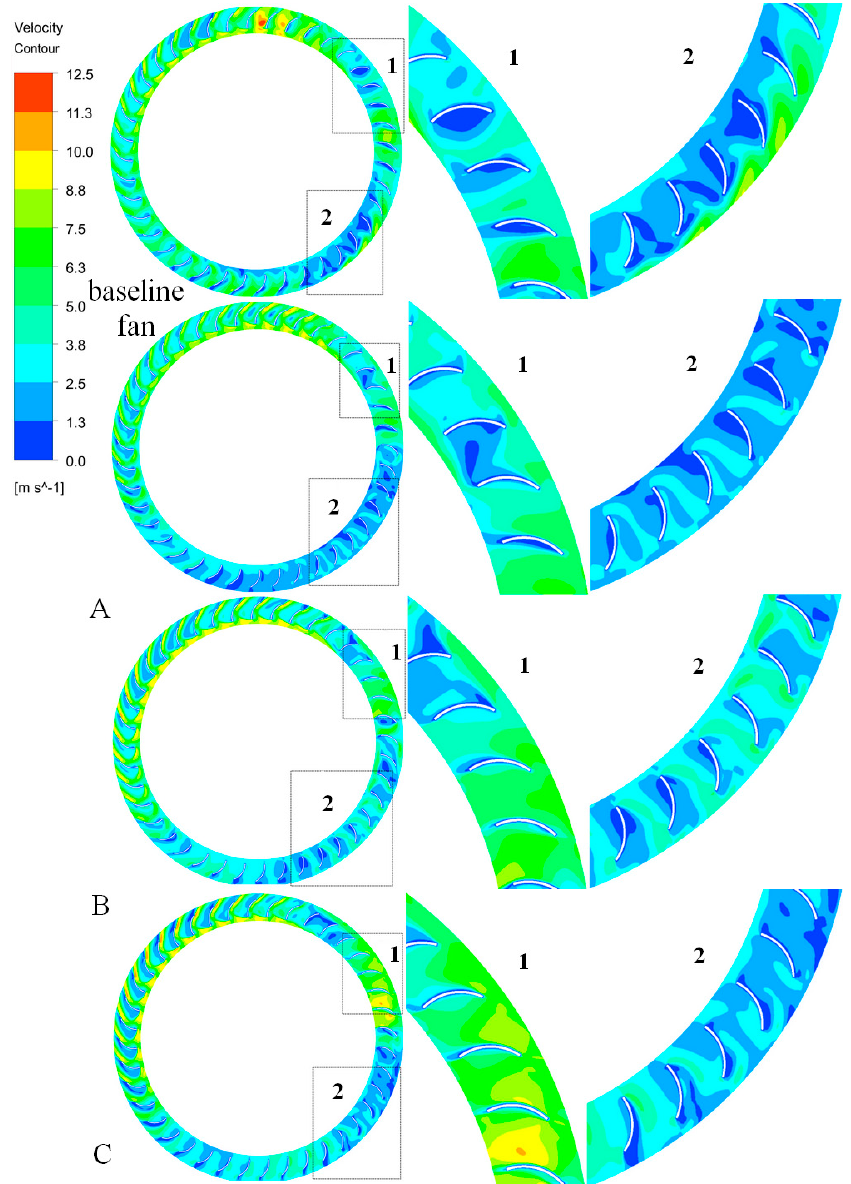
Figure 9. Magnitude of absolute velocity of the impeller for the z = 35 mm plane at a low flow rate Q / Q n = 0.483: ( A ) model-A; ( B ) model-B; ( C )